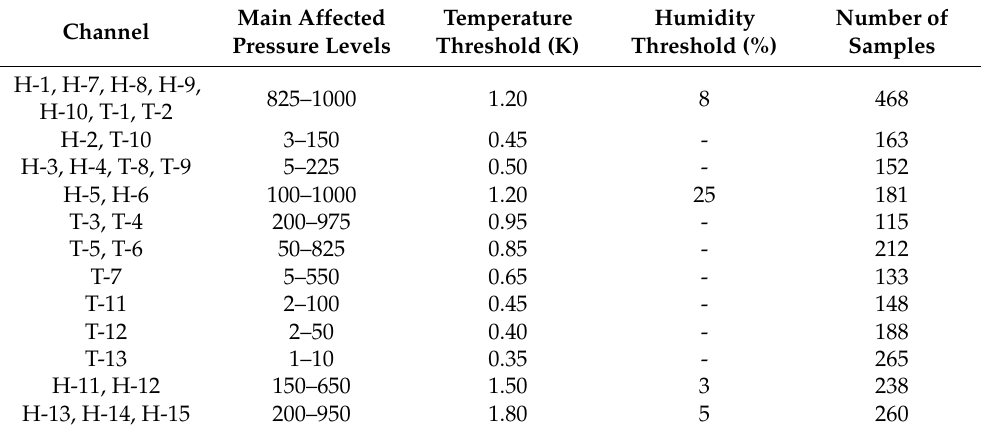
Table 4. The configuration of sensitivity test datasets for MWHTS and MWTS-II. Main Affected Temperature Humidity Number of Channel Pressure Levels Threshold (K) Threshold (%)